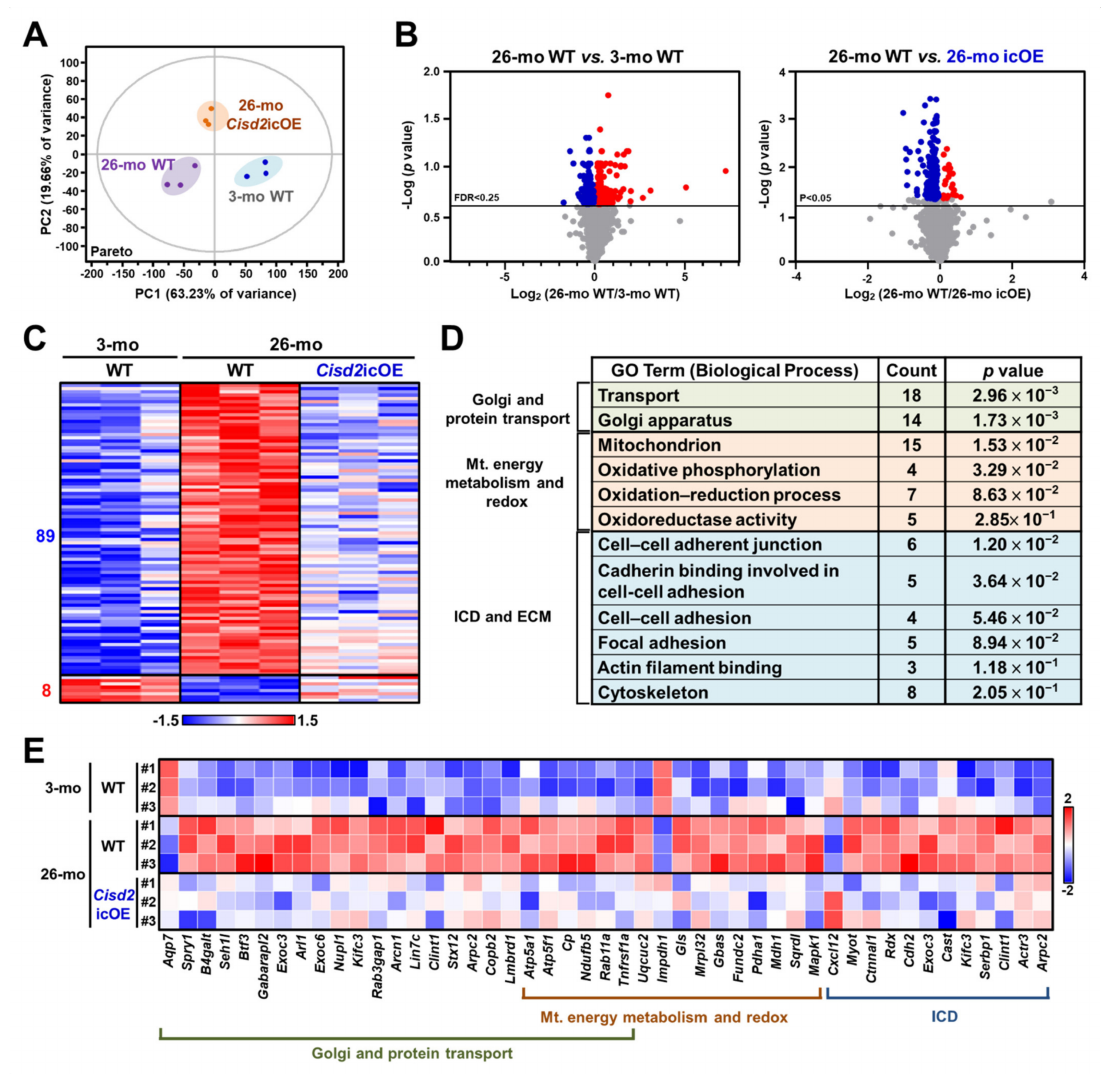
Figure 4. Cardiac-specific overexpression of Cisd2 at late-life stage in Cisd2 icOE mice reverses the cardiac transcriptomic profile changing it from an old-age pattern to a younger pattern. ( A ) Principal component analysis (PCA) of the RNA-seq data from the three groups of mice, namely 3-mo WT, 26-mo WT, and 26-mo Cisd2 icOE. ( B ) Volcano plots representing the transcriptomic changes in the 26-mo WT vs. 3-mo WT mice and in 26-mo WT vs. 26-mo Cisd2 icOE mice. The horizontal lines show the 25% false discovery rate (FDR) or the p < 0.05 threshold. Blue dots indicate the downregulated genes and red dots indicate the upregulated genes. ( C ) Heatmap showing the 97 differently expressed genes (DEGs) that are reverted by the cardiac-specific overexpression of Cisd2 in the Cisd2 icOE mice. ( D ) Analysis of the Cisd2 -reverted DEGs by the GO Biological Processes. ( E ) Heatmap showing the DEGs involved in Golgi and protein transport, mitochondrial (Mt.) energy metabolism and redox, and ICDs and ECM. ICD, intercalated disc; ECM, extracellular